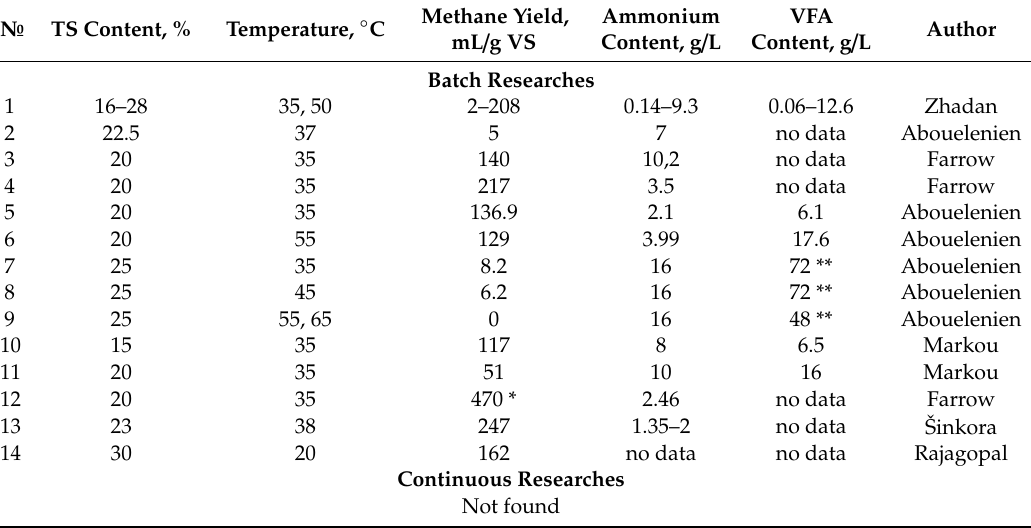
Table 3. Results of laboratory studies of chicken manure dry